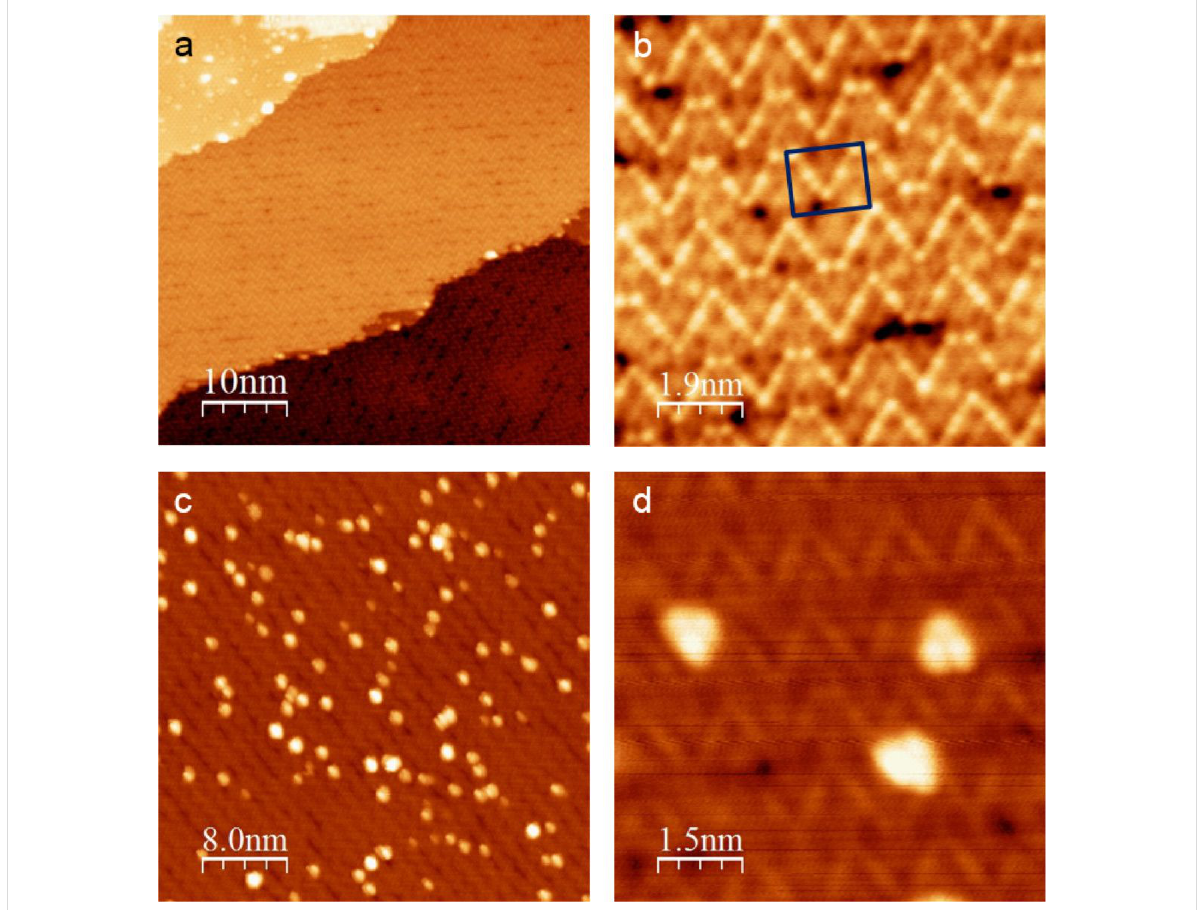
Figure 1: STM images of the z’-TiO x phase grown on Pt 3 Ti(111): (a) An overview image (50 × 50 nm; U B = 1.57 V; I T = 160 pA) of the clean oxide phase. In the upper left area, oxide-free patches of the metallic substrate can still be found. (b) An atomic resolution scan (9.4 × 9.4 nm; U B = 1.22 V; I T = 160 pA) of the z’-TiO x phase with a marked unit cell. The dark areas inside the trenches represent holes in the oxide film. (c) The z’-TiO x phase after deposition of W 3 O 9 ( ≈ 0.1 monolayer coverage; 40 × 40 nm; U B = 1.00 V; I T = 86 pA). The clusters are always aligned along the trenches. (d) A submolecular resolution scan (7.7 × 7.7 nm; U B = 1.00 V; I T = 86 pA) of individual W 3 O 9